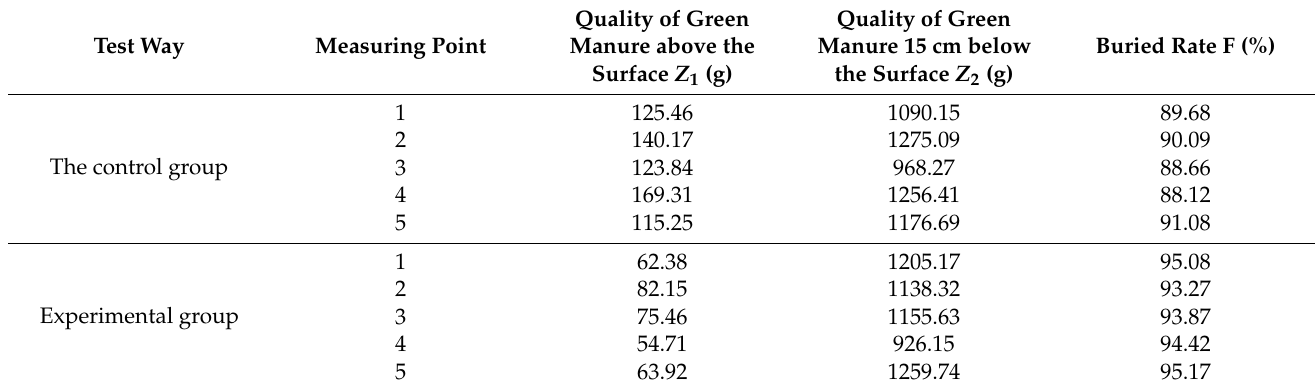
Table 5. Green manure